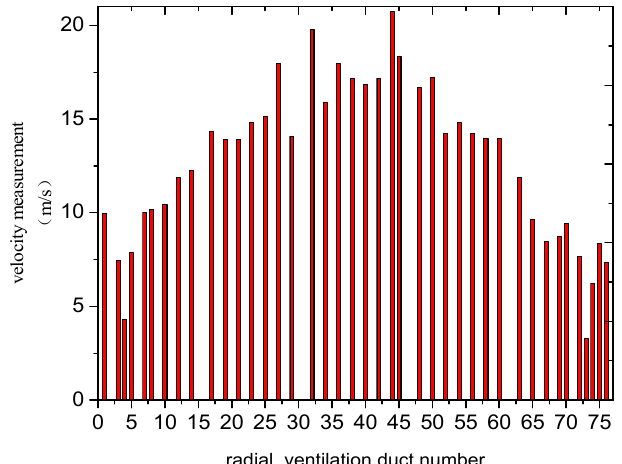
Figure 4. The distribution of wind speed values in the stator radial ventilation duct at 3000 r / min.